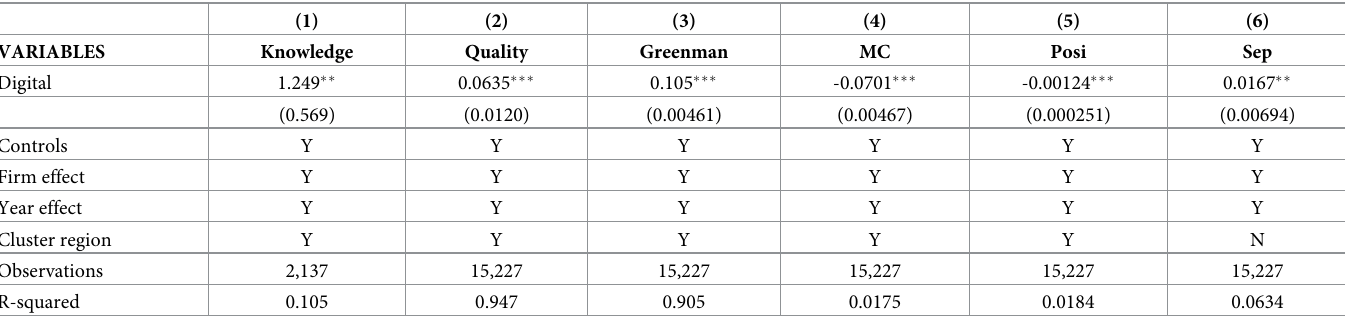
Table 8. Mechanism